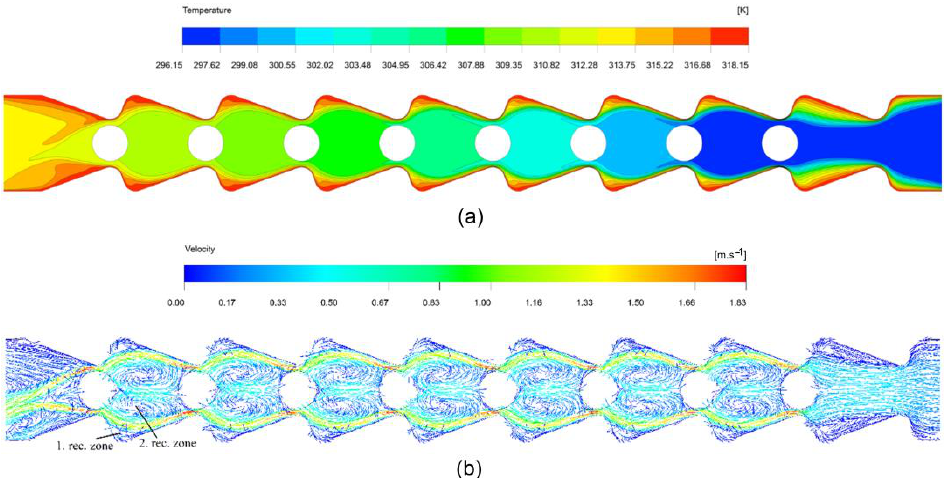
Figure 15. The temperature fields and velocity vectors of the WCCB15 (position ‘1’) for Re = 857 ( Q = 5 m 3 /h), ( a ) temperature fields along the channel, ( b ) velocity vectors along the channel.